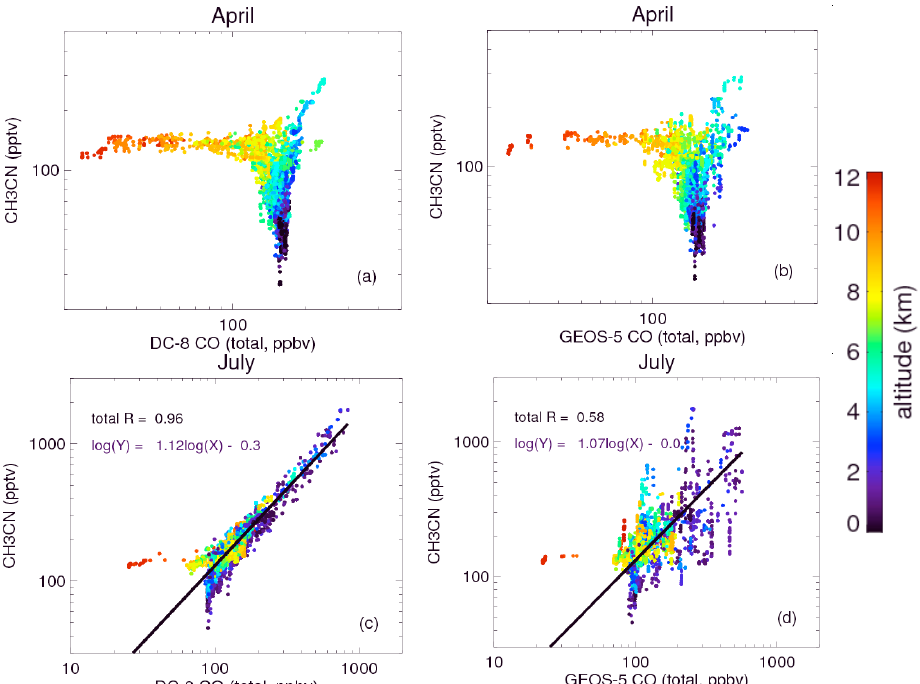
Figure 5. Scatter plots of observed CH 3 CN (pptv) and DC-­‐8 observed CO (ppbv) (a and c) and observed CH 3 CN (pptv) and GEOS-­‐5 simulated total CO (b and d) in ARCTAS-­‐A and -­‐ Fig. 5. Scatter plots of observed CH 3 CN (pptv) and DC-8 observed CO (ppbv) ( a and c ) and of observed CH 3 CN (pptv) and GEOS-5 results are colored according to the measurement altitudes. Each point represents median values of simulated total CO ( b and d ) in ARCTAS-A and -B campaigns. The results are colored according to the measurement altitudes. Each point model results and observations within 10 minutes. represents median values of model results and observations within